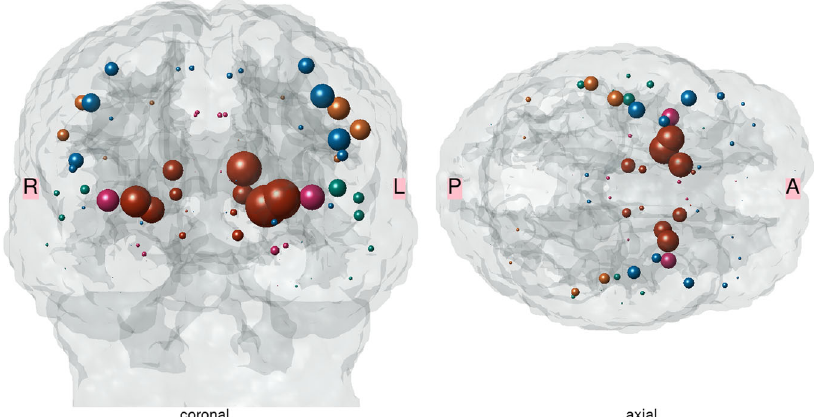
Fig. 1 Pattern and magnitude of structural disconnection induced by acute ischemic stroke lesions prior to randomization illustrated on a three-dimensional template in standard MNI space. Lesions were segmented on diffusion-weighted images (DWI) and mapped onto reference tractograms from 73 healthy subjects using the NeMo Toolbox. Spheres are located at the center of gravity of each of 86 brain regions of the Desikan – Killiany parcellation. Volume indicates magnitude of average change of connectivity with larger sizes indicating higher degree of disconnection. Colors indicate assignment of brain regions to frontal (cerulean), parietal (sun), temporal (dark cyan), occipital (summer sky) and limbic (violet red) lobes, or subcortical structures (orange). In the coronal section, the brain template is shown using the neurological convention. This Figure was created using the NeMo toolbox 39